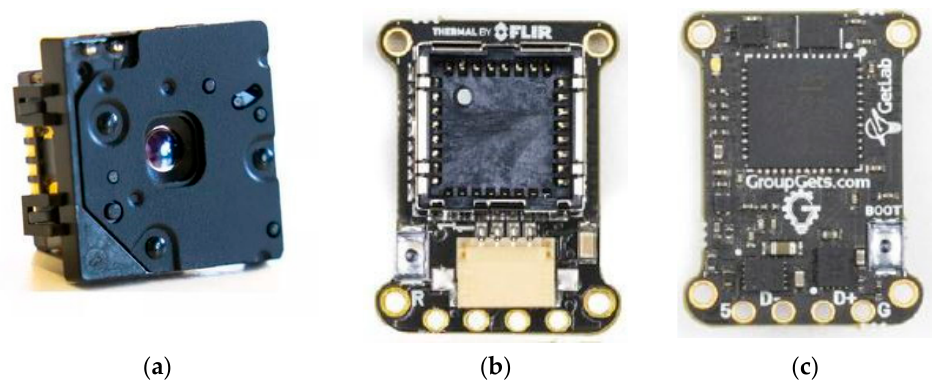
Figure 1. Modules chosen for the development of the low-cost hot-spot detection system. ( a ) Photo- graph of the FLIR Lepton 3.5 module. ( b ) PureThermal Mini Pro JST-SR Lepton Smart I/O (Socket, front view). ( c ) PureThermal Mini Pro JST-SR Lepton Smart I/O (CPU, rear view).